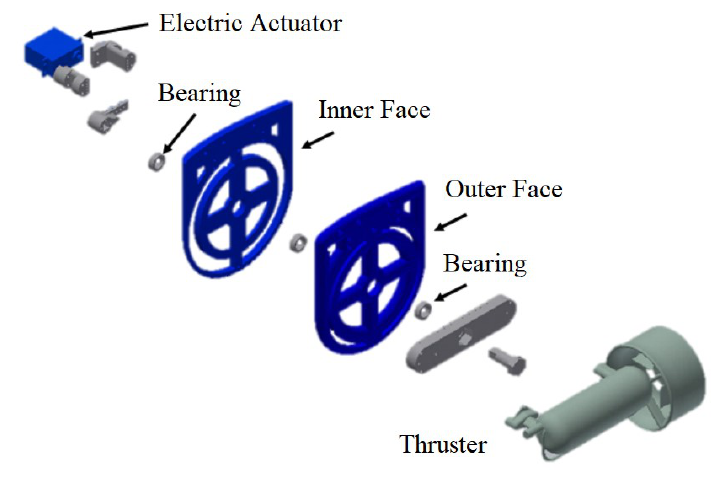
Figure 5. Parts of the structure designed to obtain a thruster vector control on the vertical